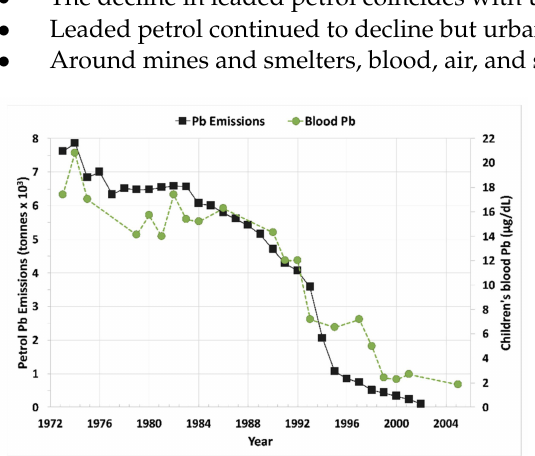
Figure 5. Blood Pb increases and decreases from 1973 to 2005 correspond with increases and decreases in leaded petrol emission ending during 2002 in Australia. Although the leaded petrol emissions continued to decrease, blood Pb stabilized at around 2 µ g/dL. Revised and redrawn from [19].